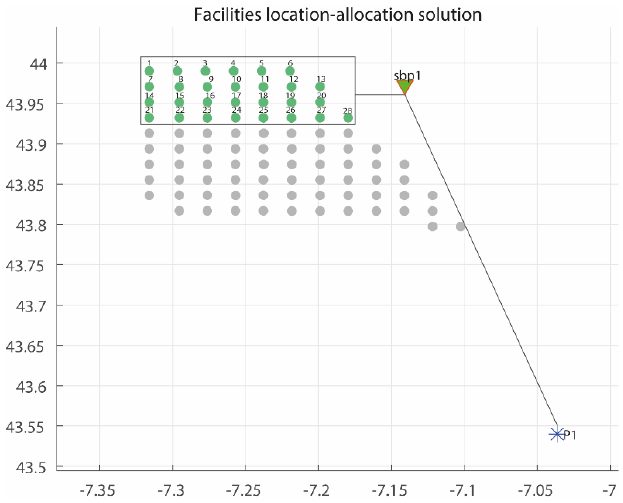
Figure 3. Facility location–allocation solution, where the green dots mean that all the turbines are allocated to the chosen stand-by point.